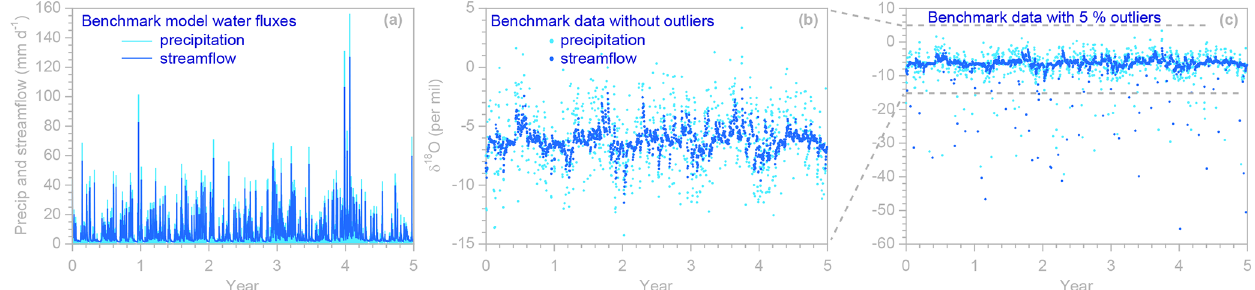
Figure 1. Benchmark model daily water fluxes (a) and precipitation and streamflow isotope time series (light and dark blue symbols, respectively), without outliers (b) and with 5% outliers (c) . The axis frame of the outlier-free data (b) corresponds to the dashed lines in panel (c) . Benchmark model parameters are S u, ref = 50mm, S l, ref = 2000mm, b u = 10, b l = 3, and η = 0.8. The model is driven by a daily precipitation time series from Plynlimon, Wales, and a hypothetical precipitation δ 18 O isotope record with a seasonal sinusoidal amplitude of 1.2‰, a normally distributed random standard deviation of 2.5‰, and a serial correlation of 0.5 between successive daily isotope values. A random measurement error with a standard deviation of 0.1‰ was added to all simulated precipitation and streamflow isotope measurements.